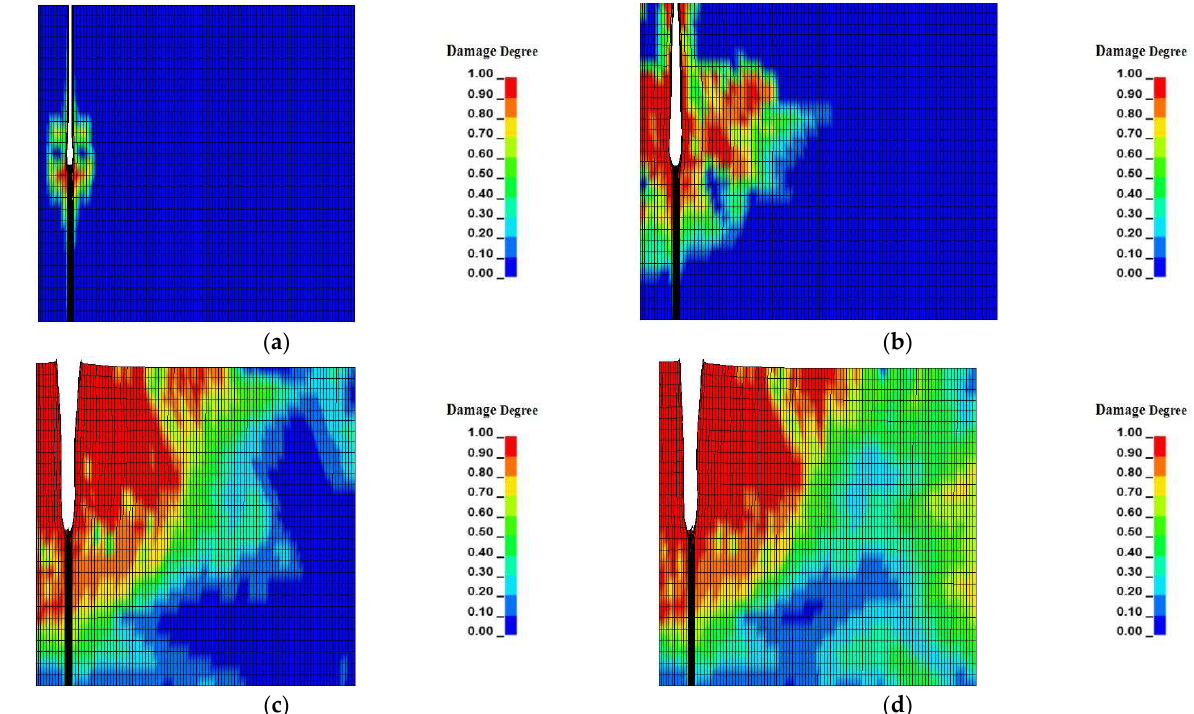
Figure 15. Blasting damage evolution law of surrounding rock along the longitudinal direction of tunnel (Plane y = 0 m). ( a ) t = 0.1 ms. ( b ) t = 0.5 ms. ( c ) t = 1.5 ms. ( d ) t = 3.0 ms.